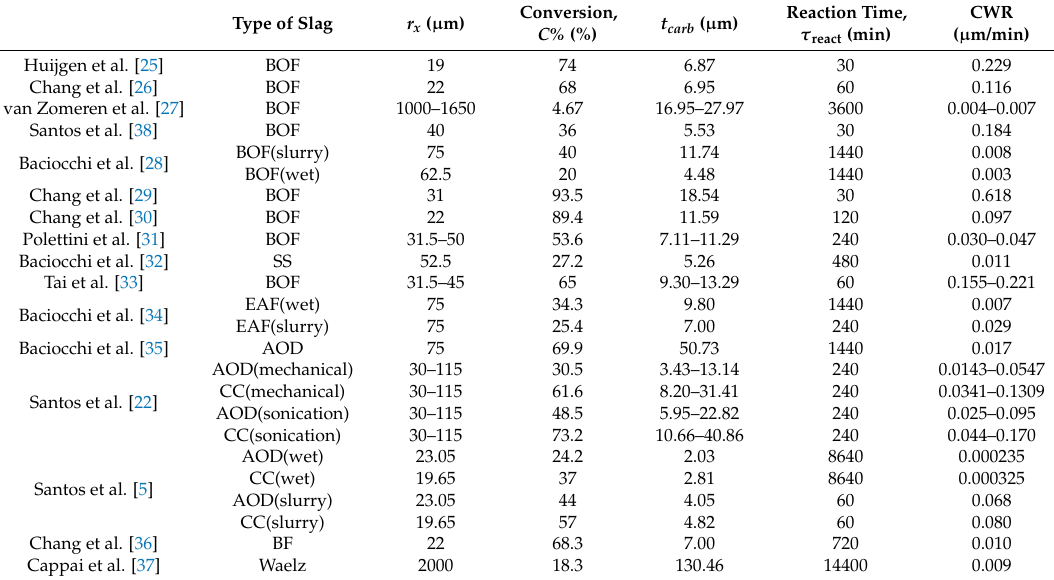
Table 4. Summary of slag and process parameters from different carbonation studies and the resulting calculated carbonation weathering rate (CWR) [10]. Re-used with permission from John Wiley